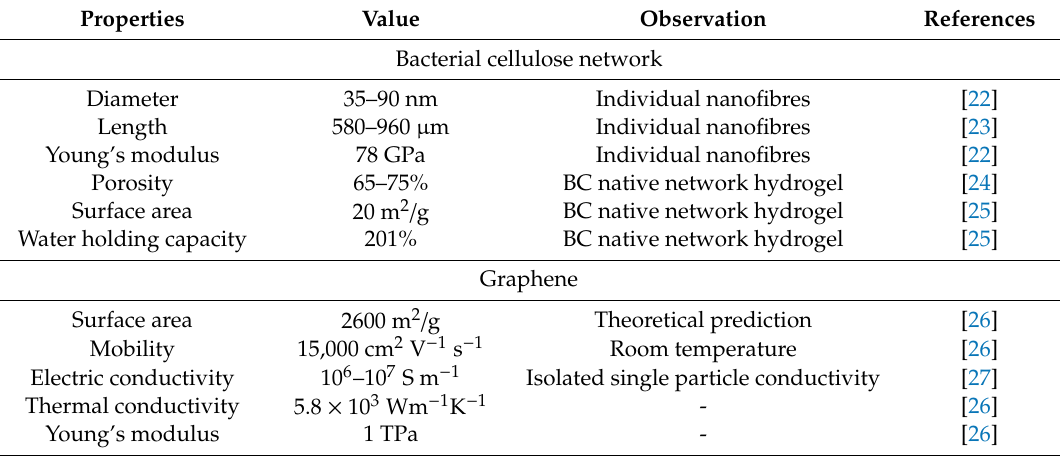
Table 1. Summary of bacterial cellulose (BC) and graphene